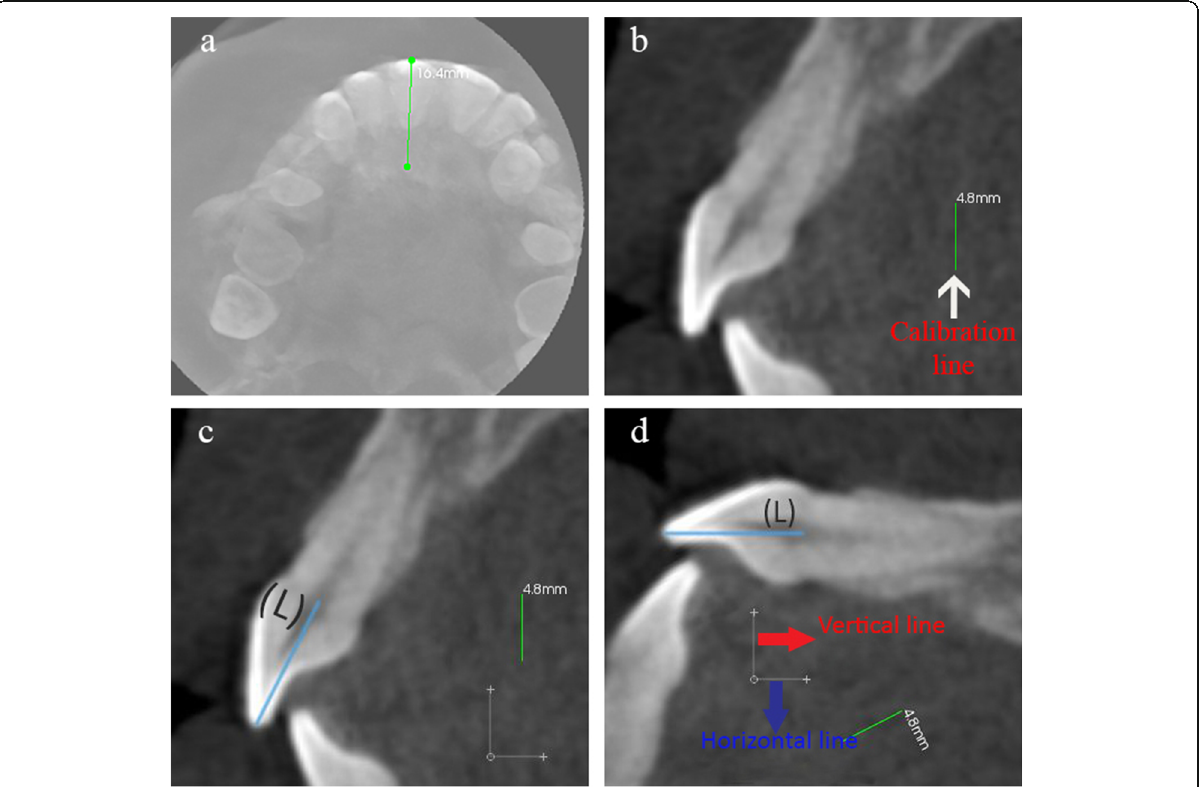
Fig. 1 a Labio-palatal axis of RMCI (drawn line) was crossed by the sagittal plane indicator in the axial slice of CBCT image. b Sagittal slice of CBCT image showing proximal aspect of RMCI and calibration line. c The red line joins palatal and labial CEJs, while blue line (L) represents crown ’ s long axis. d Image rotation was done such that line (L) became